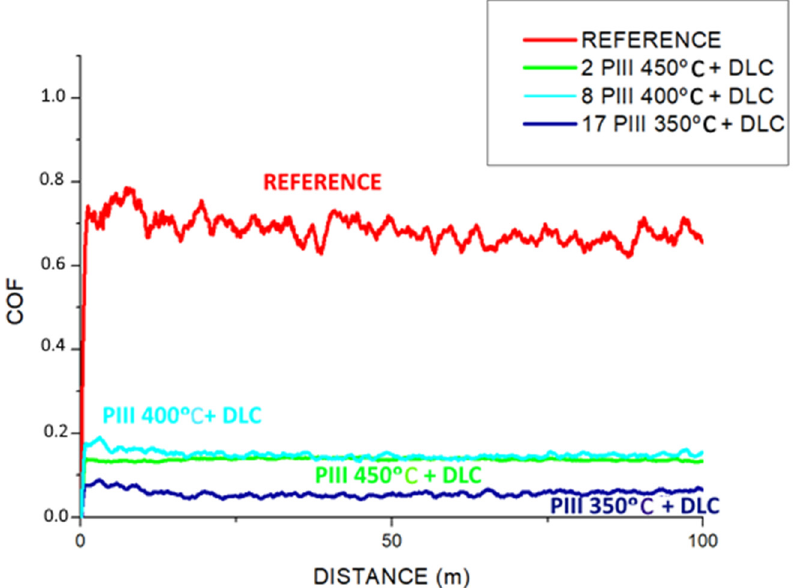
Figure 16. Friction coefficients of the PIII 450 °C + WC:C coating (red line), PIII 400 °C + WC:C coating (blue line), PIII 350 °C + WC:C coating (purple line) and the reference AISI 316-L (green line) under 5 N.